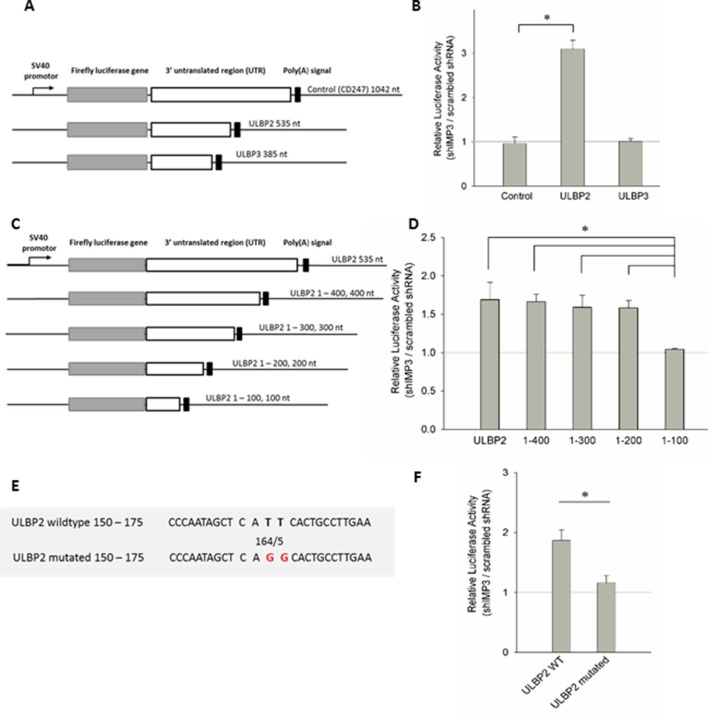
Post-transcriptional effects of IMP3 on ULBP2 mRNA assessed by luciferase assay.(A) Schematic representation of the luciferase constructs used for this assay with the 3’UTRs of the ULBP family members including their lengths in nucleotides (nt). (B) The 3‘UTRs of ULBP 1, 2, 3 and CD247 (as control) were fused to the luciferase gene as shown in A and expressed in RKO cells transduced either with scrambled shRNA or with shIMP3. 28 hr after transfection of the luciferase vectors, luciferase activity was measured. The results were normalized to empty vector control and statistics were performed based on data acquired for the control UTR (CD247). Figure shows merged data of three independent replicates *p=0.023 in student’s t-test. (C) Schematic representation of the truncation mutants of the ULBP2 3’UTR. (D) Luciferase assay with the 3’UTR of ULBP2 and shortened variants presented in (C), expressed in RKO cells transduced either with scrambled shRNA or with shIMP3. Shown is merged data of three independent replicates. The luciferase activity of the fragment ranging from 1–100 bp was significantly lower than the activity of the fragment 1–200 bp (*p=0.002), 1 300 bp (*p=0.006), 1–400 bp (*p=0.041) and the full 3'UTR (*p=0.010) (E) Schematic representation of the ULBP2 3’UTR sequences areas that were mutated. The putative binding motif CATT is shown in loose characters (positions 161 – 164). The introduced mutations in the 3’ UTRs (CAGG) are shown in red letters. (F) The wild type (WT) or mutated 3’UTRs (as shown in A) of ULBP2 was transiently expressed in RKO cells transduced with scrambled shRNA or with shRNA IMP3. Luciferase activity was assayed 28 hr after transfection. Shown is merged data of three independent replicates. *p<0.001 in student’s t-test.